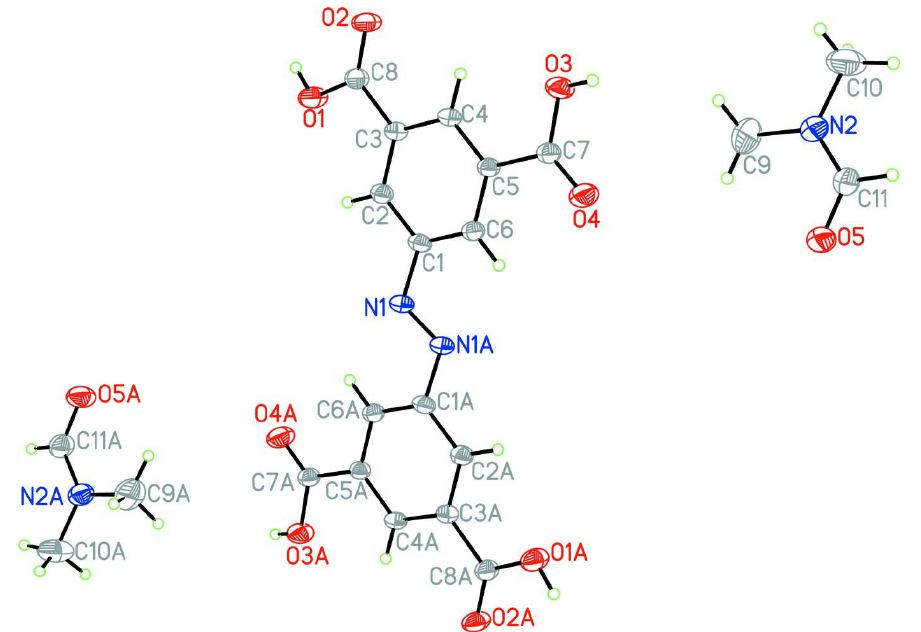
Figure 1 The molecular structure of the title compound with the atomic numbering scheme. Displacement ellipsoids were drawn at the 30% probability level. [Symmetry code: (A) -x+3, -y,